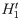
Partitioning Ht of a three ploid genome.The yellow parts indicate H1t and the green parts demonstrate H2t. It must be pointed out that H1t=H1,1t∪H1,2t∪H1,3t.